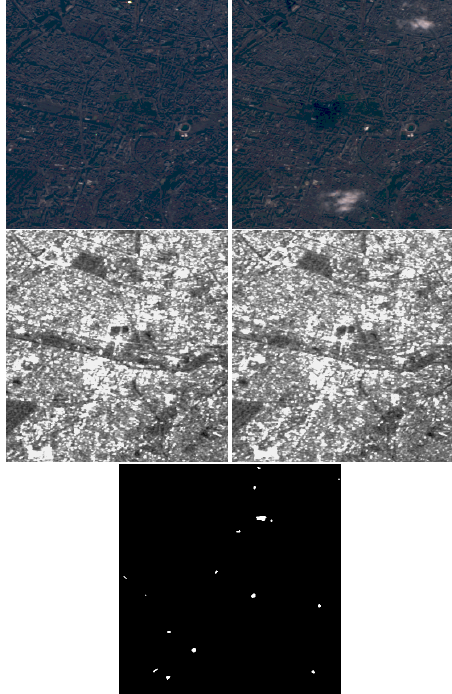
Figure 1. Multi-modal observations and change map for exemplary ROI ’Paris’. Rows: Sentinel-2 data (RGB channels). Sentinel-1 data (VV-polarized). Change maps. Columns: Time point 1. Time point 2. The images highlight the differences between both modalities and the potential complementary information they may provide to benefit change